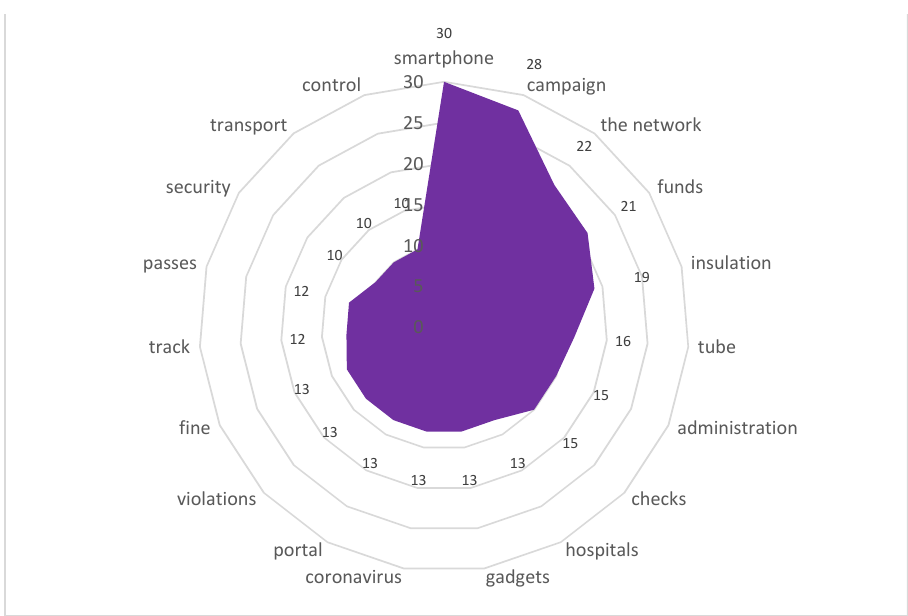
Figure 19. Associative network for stimulus surveillance camera